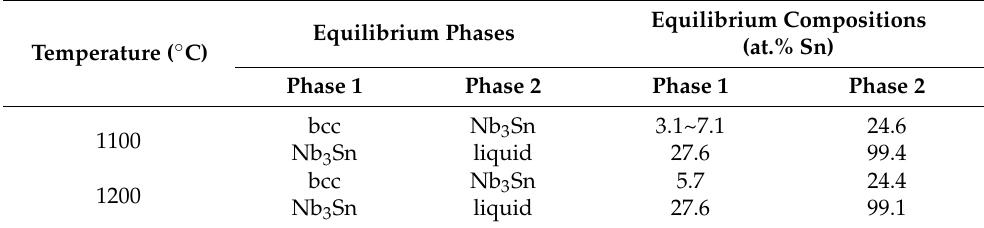
Figure 5. Comparison between the experimental composition profiles measured in this study and the Nb-Sn binary phase diagram calculated according to the thermodynamic parameters assessed by Toffolon [19]. Table 1. Equilibrium compositions for different phases measured from the Nb/Sn LSDCs.